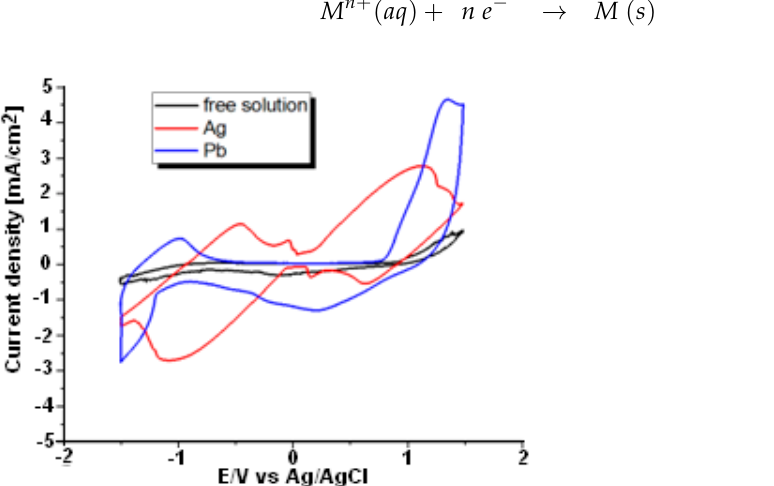
Figure 2. Cyclic voltammogram: black color free solution, red and blue colors presence of Ag and Pb in an aqueous solution, respectively. Scan speed is 60 mV/s.